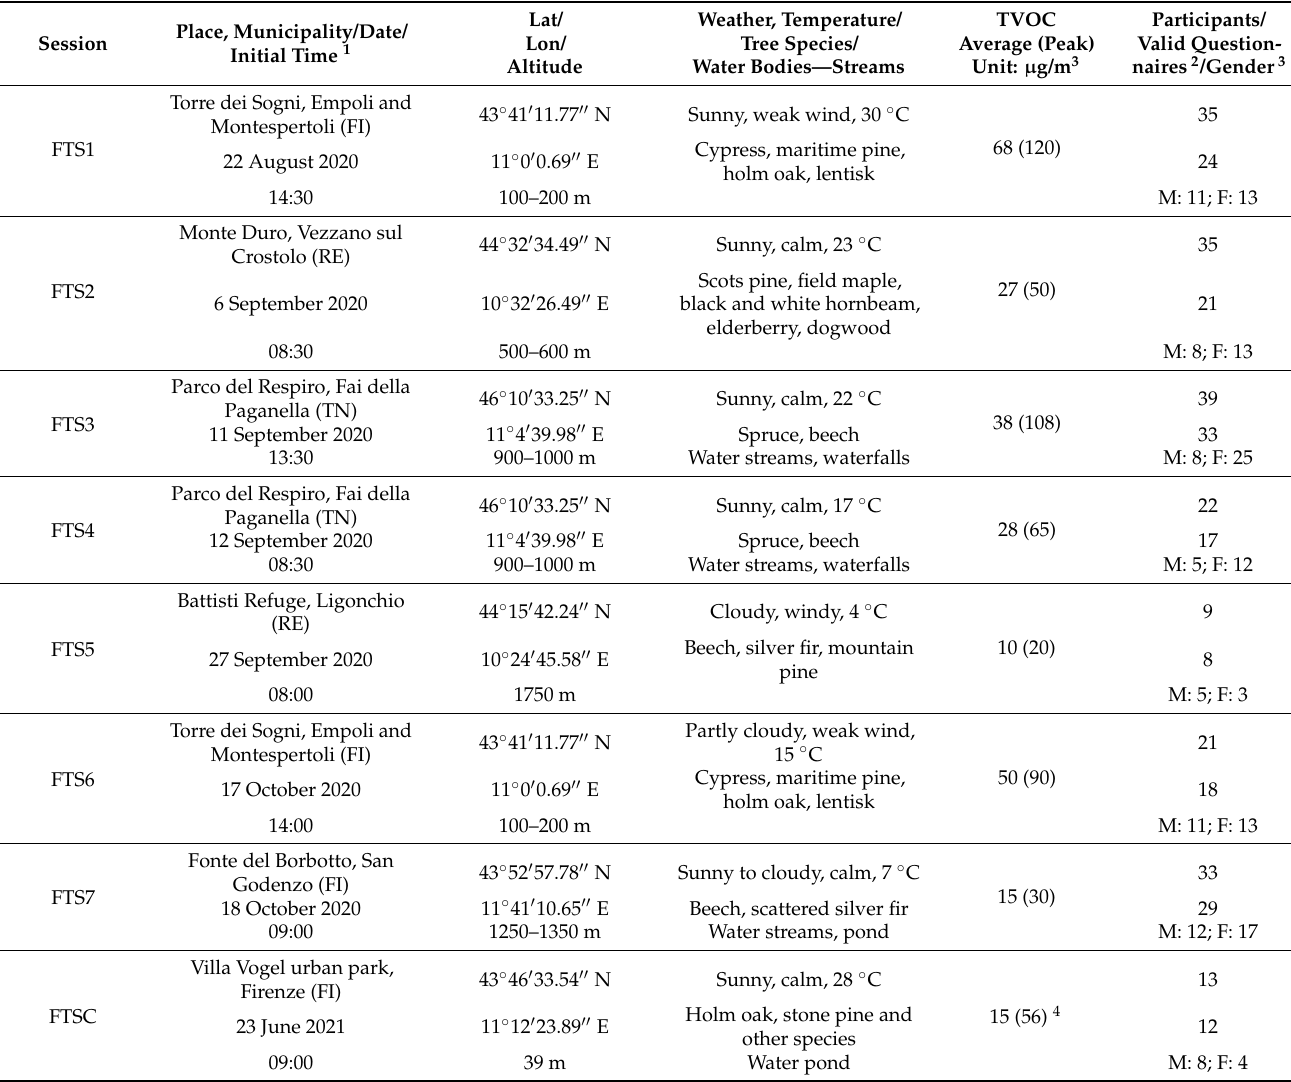
Table 1. Basic features of forest therapy sessions performed in